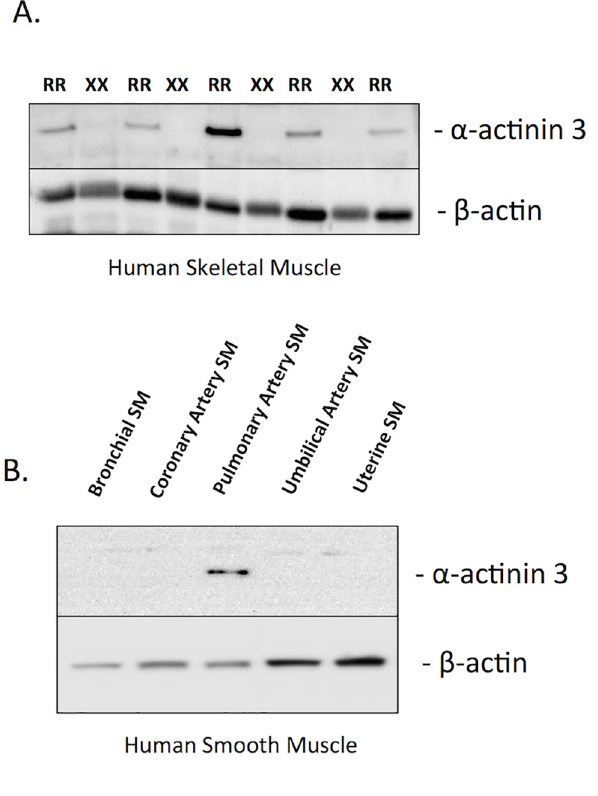
Fig 1. The expression of alpha-actinin-3 in human skeletal muscle and pulmonary artery smooth muscle. Shown are A) A rabbit polyclonal alpha-actinin 3 antibody probed against skeletal muscle samples from ACTN3 RR577 and 577XX individuals from the STRRIDE Study [30]. B ) This same antibody probed against human smooth muscle (SM) cell panel. Each lane contains 50 ug of protein extract, which were stripped and reprobed with a beta-actin antibody as a loading control.